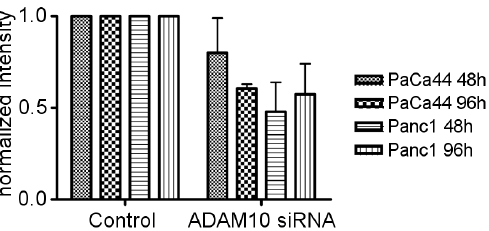
Figure 7. ADAM10 mediates Fat1 ectodomain shedding. Western blot analysis of secretome fractions (8 m g) from PaCa44 and Panc1 cells after ADAM10 knockdown (compare Figure 6) showed significant reductions in Fat1 ectodomain shedding. Again, the two experiments provided similar results as indicated by the normalized quantification.